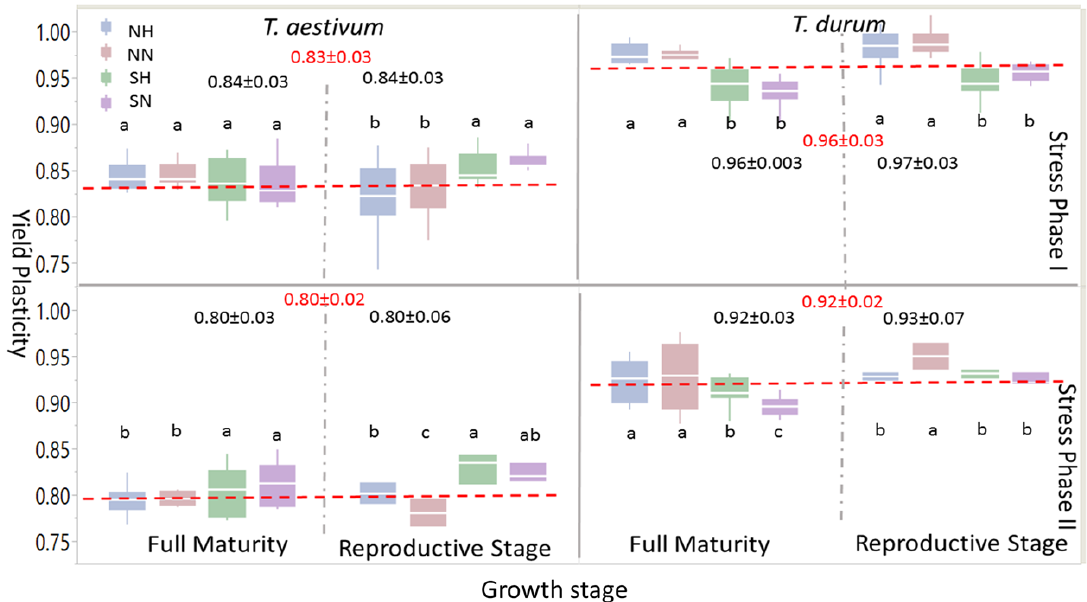
Figure 4. Box-plots and mean separation (means followed by the same letter within each growth stage do not differ significantly using Tukey’s HSD; p = 0.05) of grain yield phenotypic plasticity estimates for two wheat genotypes representing T. durum and T. aestivum subjected to three levels of abiotic stresses (NH, normal length of growing season and high population density, SN, short growing season and normal population density, and SH, short growing season and high population density) and compared to a control (NN, normal length of growing season and normal population density) during reproductive and full maturity growth stages.